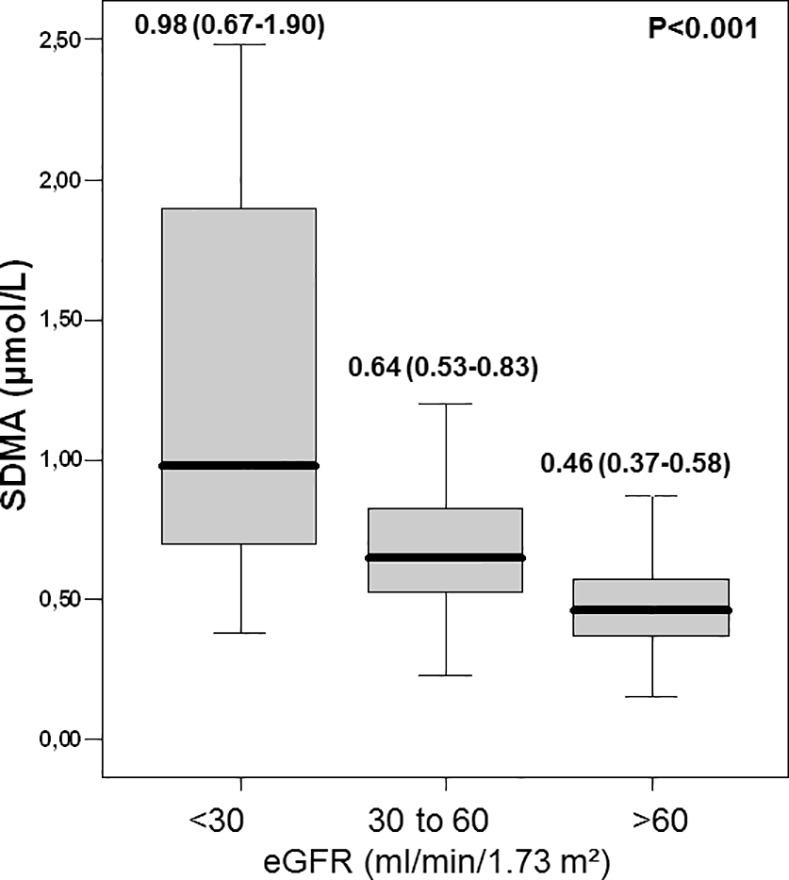
Symmetric dimethylarginine concentrations according to estimated Glomerular Filtration Rate (p value for comparison between the tertiles).